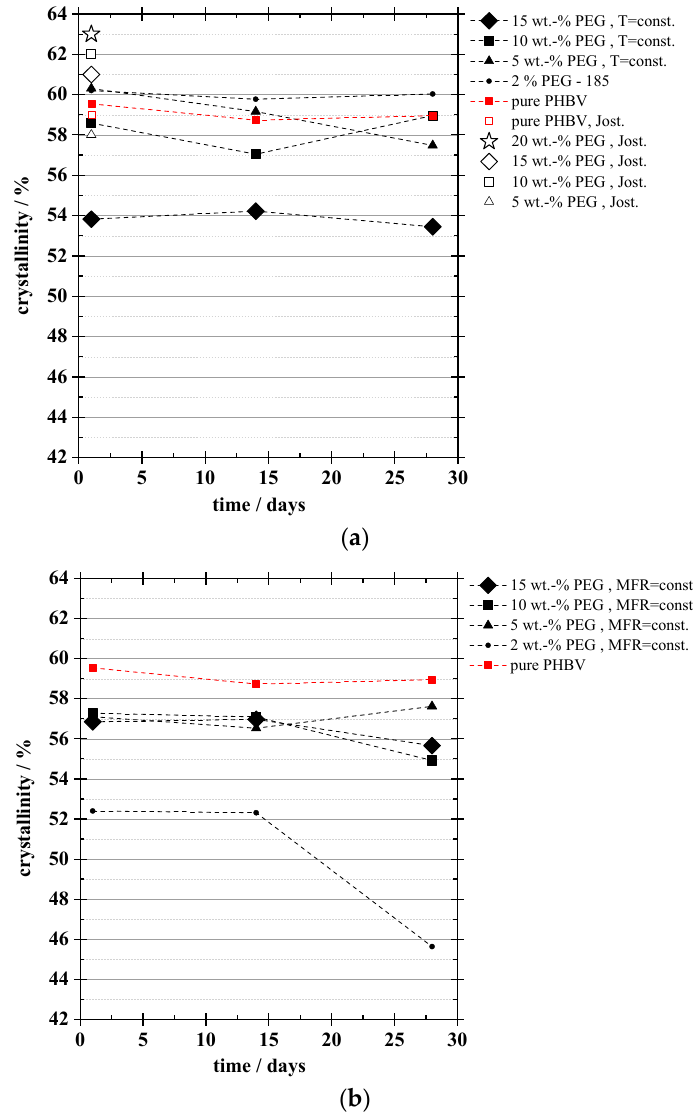
Figure 4. Crystallinity as function of time of PHBV layers blended with PEG: ( a ) temperature (T) during extrusion constant; ( b ) melt flow rate (MFR) during extrusion constant.